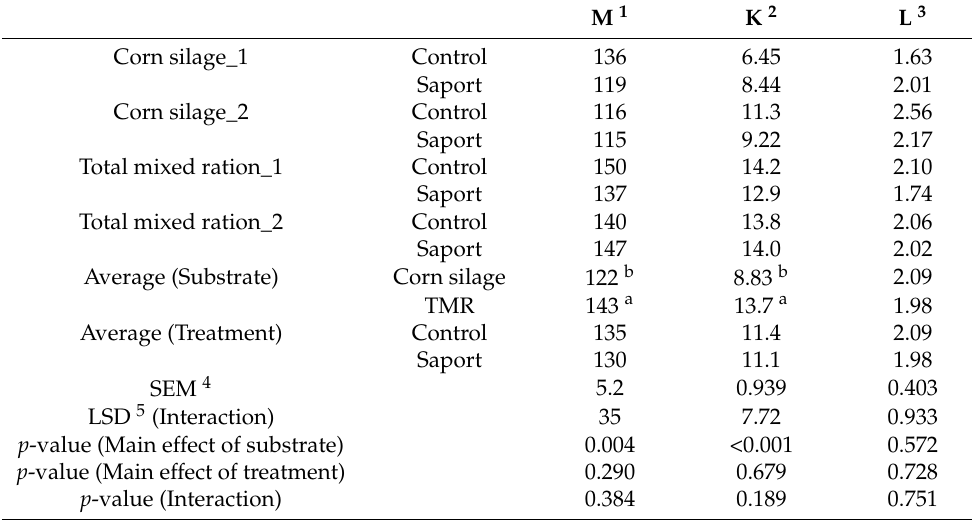
Table 2. Effects of treatments on fermentation characteristics of four dairy